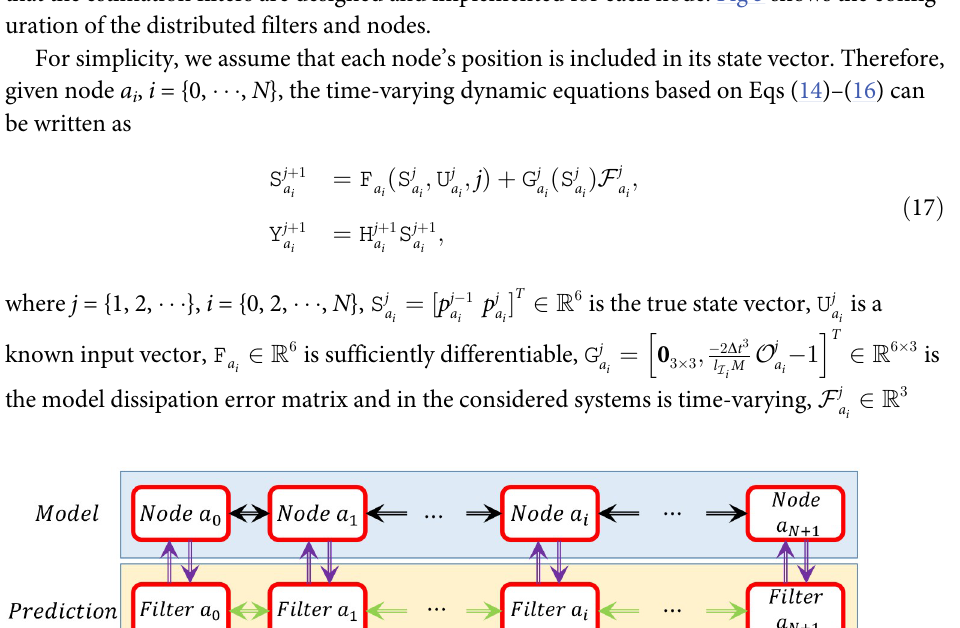
Fig 3. Configuration of the nodes of the model and the corresponding distributed filters. Filter a coupled with the adjacent nodes in